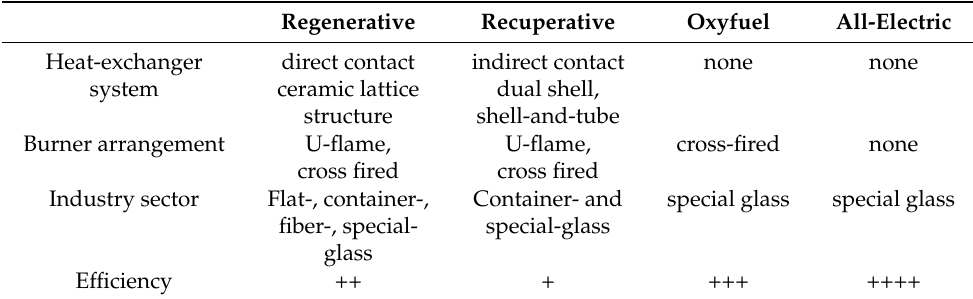
Table 1. Comparison of key values for established melting tank designs. As efficiency depends on several factors (e.g., glass type, melting capacity, fuel) only a qualitatively assessment can be provided. An increasing number of “+” indicates higher efficiency [12–18]. Regenerative Recuperative Oxyfuel All-Electric Heat-exchanger direct